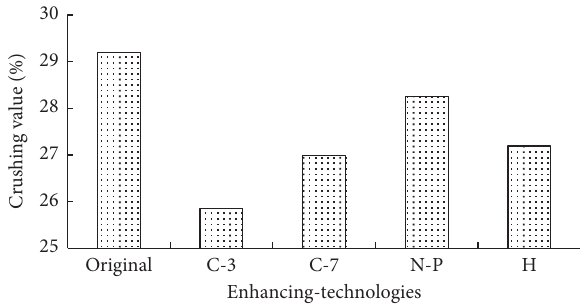
Figure 6: Crushing value of RA before and after chemical en- hancing-technology.